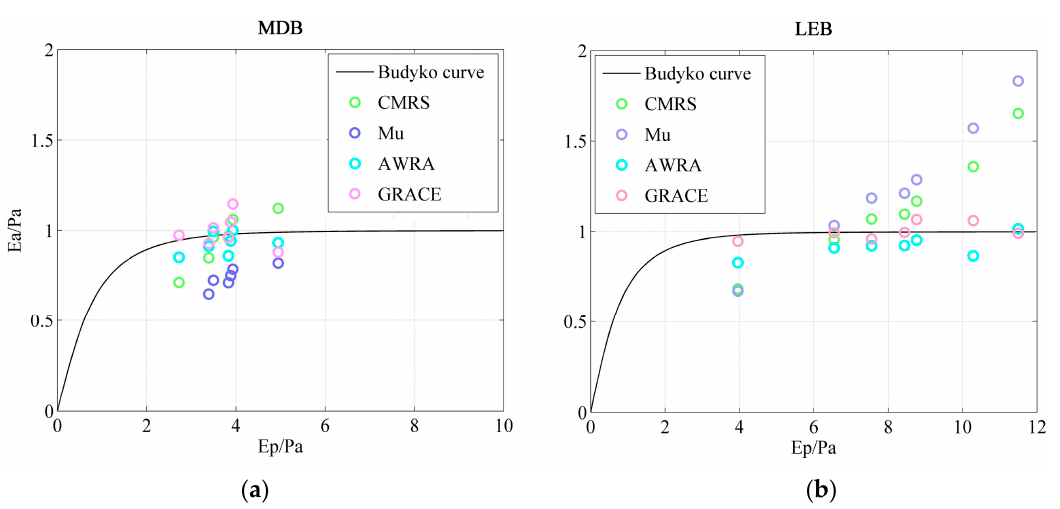
Figure 7. Budyko diagrams for the MDB (a) and the LEB ( b ). Ea represents the annual ET estimated by PT-CMRS, PM-MU, AWRA and GRACE. Pa is annual rainfall. Ep is potential evapotranspiration based on the Priestley–Taylor method. All the terms were computed for each hydrological annual year from 2003 to 2010.